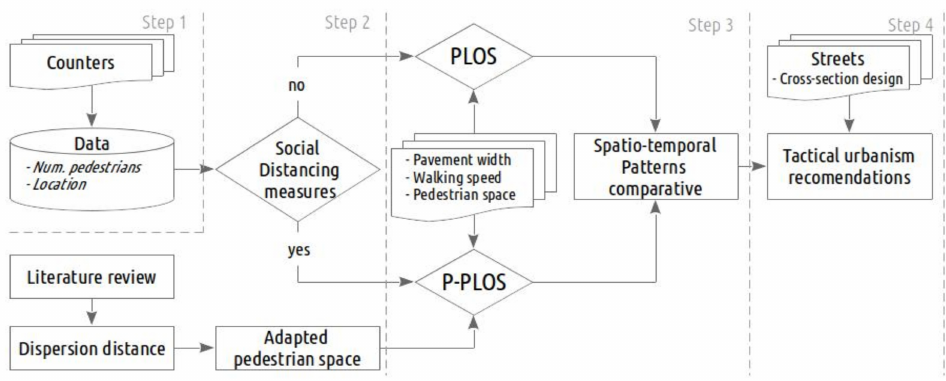
Figure 2. Methodology